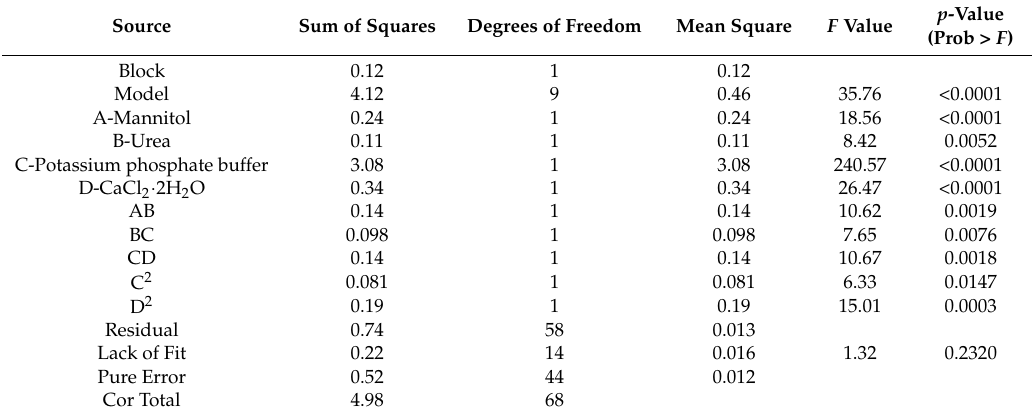
Table 6. ANOVA for the regression model of rhamnolipids production obtained from CCD results. Source Sum of Squares Degrees of Freedom